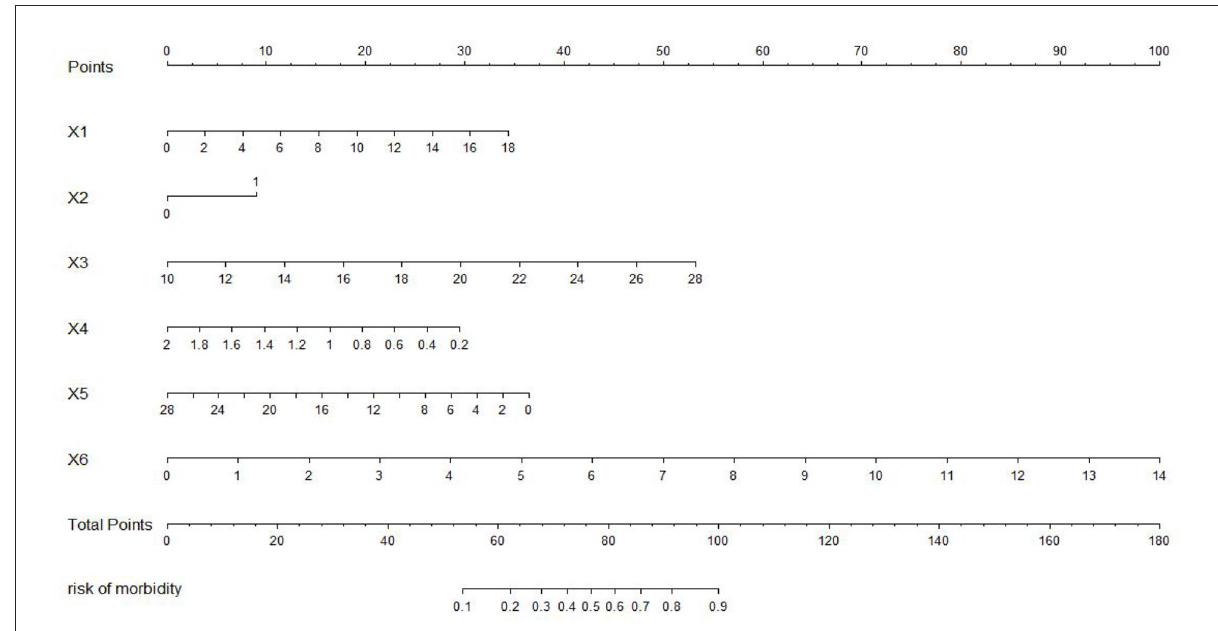
FIGURE11 Nomogram of the prediction model. X 1 , age; X 2 , persistent skin purpura; X 3 , erythrocyte distribution width; X 4 , complement C3; X 5 , immunoglobulin G; X 6 , triglyceride.